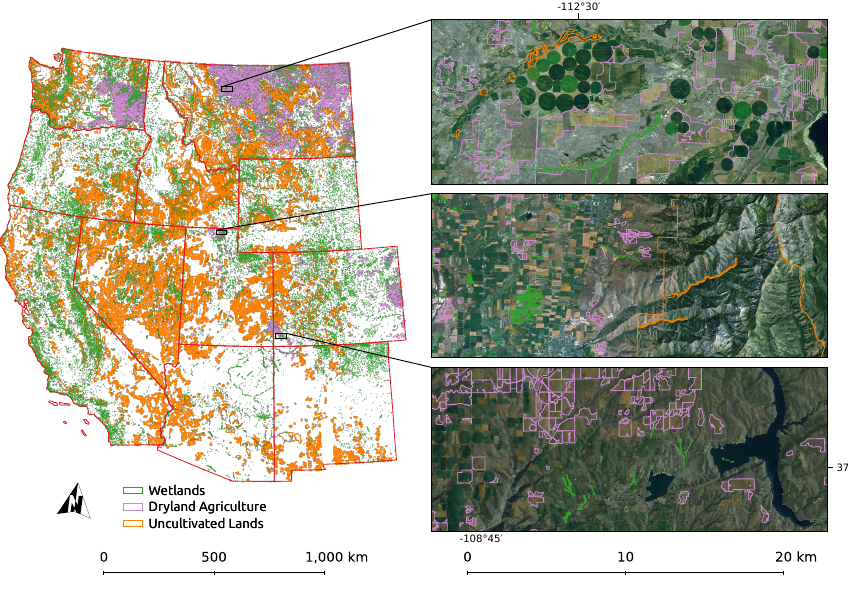
Figure 3. Training data from the unirrigated classes used to train IrrMapper (i.e., wetlands, dryland agriculture, and uncultivated lands). Table 1 shows the number of polygons and total training area from each class in each of the 11 Western